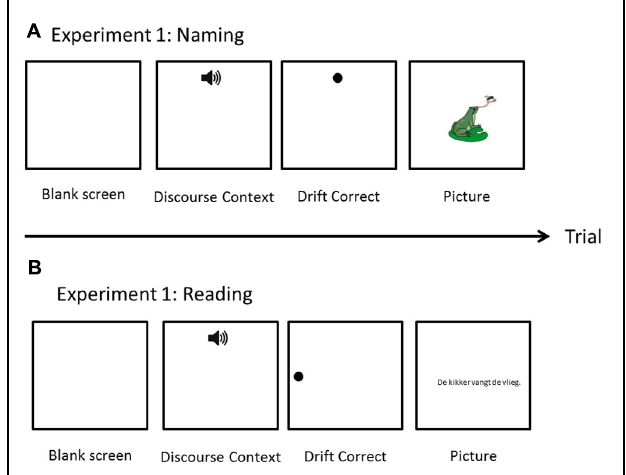
FIGURE 2 | Schematic representation of a trial for Naming (A) and Reading (B) experiments.